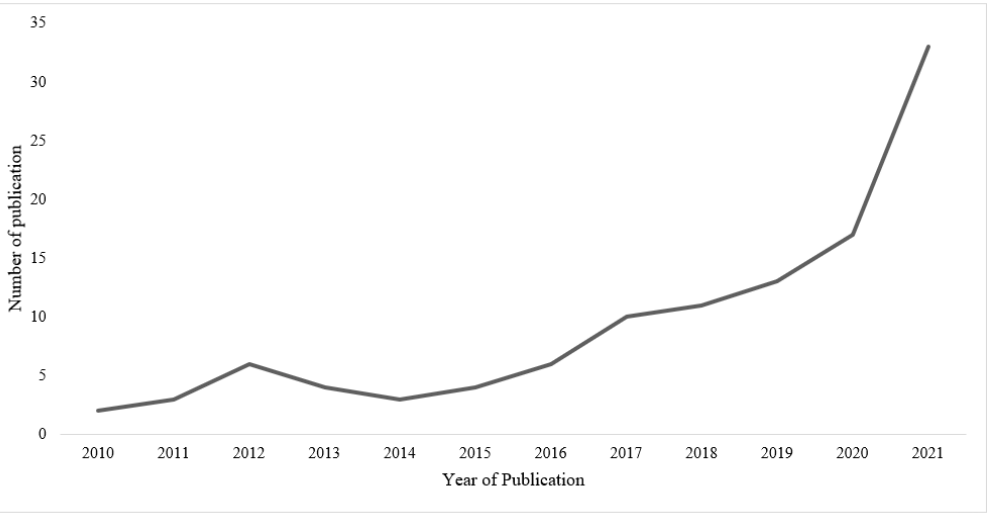
Figure 3. Evolution of the number of publications addressing factors influencing aquatic food consumption behavior among Asian consumers. Publication published after 31st December 2021 was limited and therefore removed in the graph.